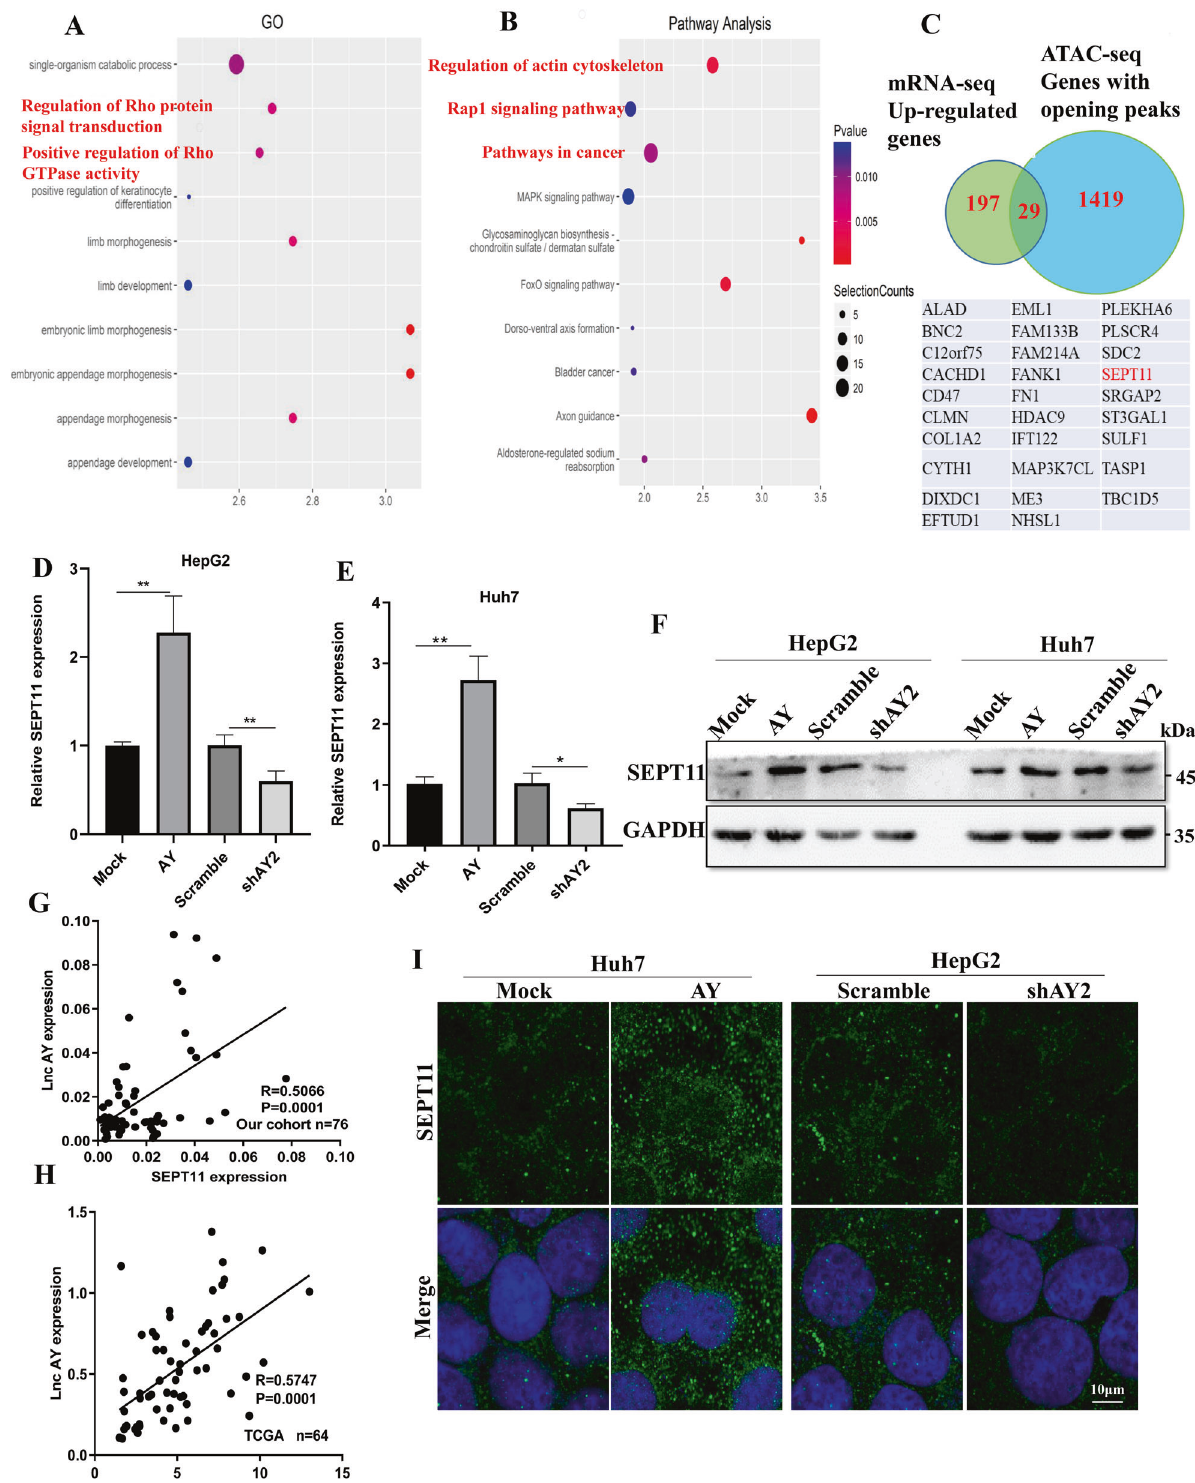
Fig. 1 AY regulated the expression of SEPT11 in HCC cells. A GO analysis of genes with open sites in ATAC-seq; B KEGG analysis of genes with open sites in ATAC-seq; C aggregation of genes upregulated in mRNA-seq and with open sites in ATAC-seq; D , E After overexpression and shAY, the transcription level of SEPT11 was detected by QPCR, * means p < 0.05, ** means p < 0.01, the same below; F After overexpression and shAY, the protein content of SEPT11 was detected by WB; G after QPCR detection of 76 cases of HCC and paired paracancerous tissues, the correlation between AY and SEPT11 expression was analyzed (samples with less than 35 CT values were retained); H The correlation between AY and SEPT11 expression was analyzed according to the expression pro fi le of HCC in TCGA database; I the expression of SEPT11 protein after overexpression and shAY was observed by cellular immuno fl uorescence combined with confocal microscopy.